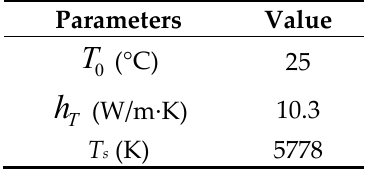
Table 2. Environmental properties for the climatic condition of